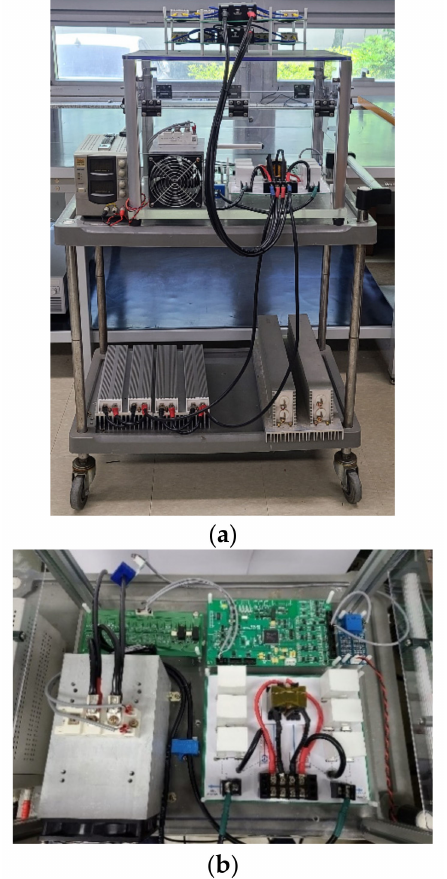
Figure 8. Experimental set-up of the SSCB-CI: ( a ) overall test circuit configuration and ( b ) inner structure.